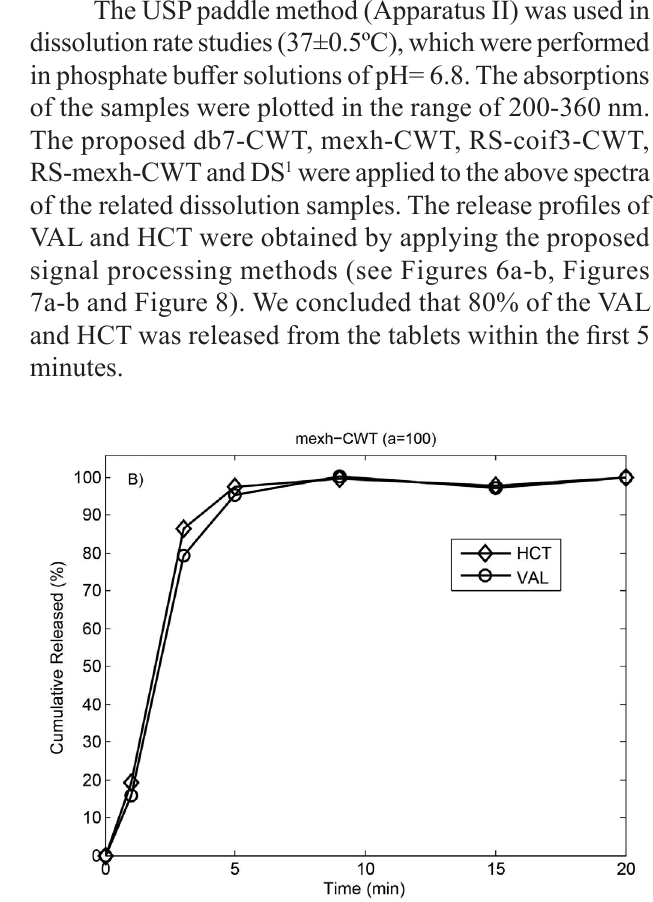
FIGURE 6B - Dissolution profiles of VAL and HCT obtained by applying mexh-CWT